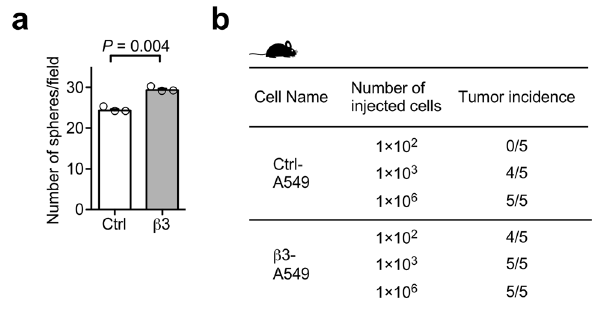
Fig. 4 Enhancement of cancer stemness by α v β 3 integrin expression. a In vitro sphere assay of control and β 3-A549 cells. Two-tailed unpaired Student ’ s t -test, mean ± s.e.m. of three independent assays conducted in triplicate. The source data are provided in Supplementary Data 1. b In vivo tumor initiation assay at 4 weeks after subcutaneous injection of the indicated number of control and β 3-A549 cells in nude mice. n = 5 mice per